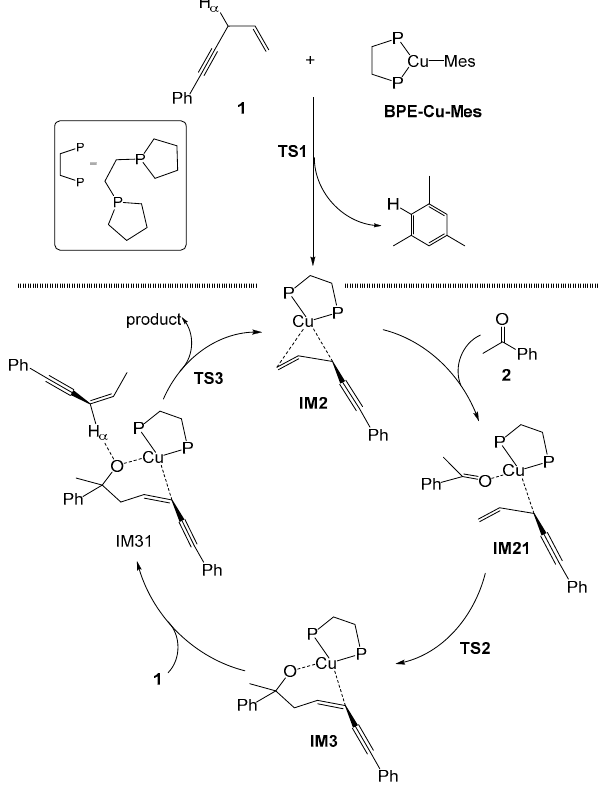
Scheme 1. Schematic diagram of the reaction process in the BPE-ligated system.